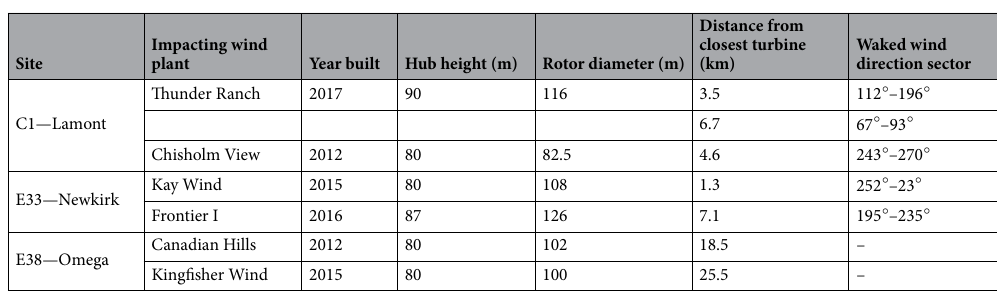
Table 1. Main characteristics of the wind plants in the vicinity of the sites considered in the